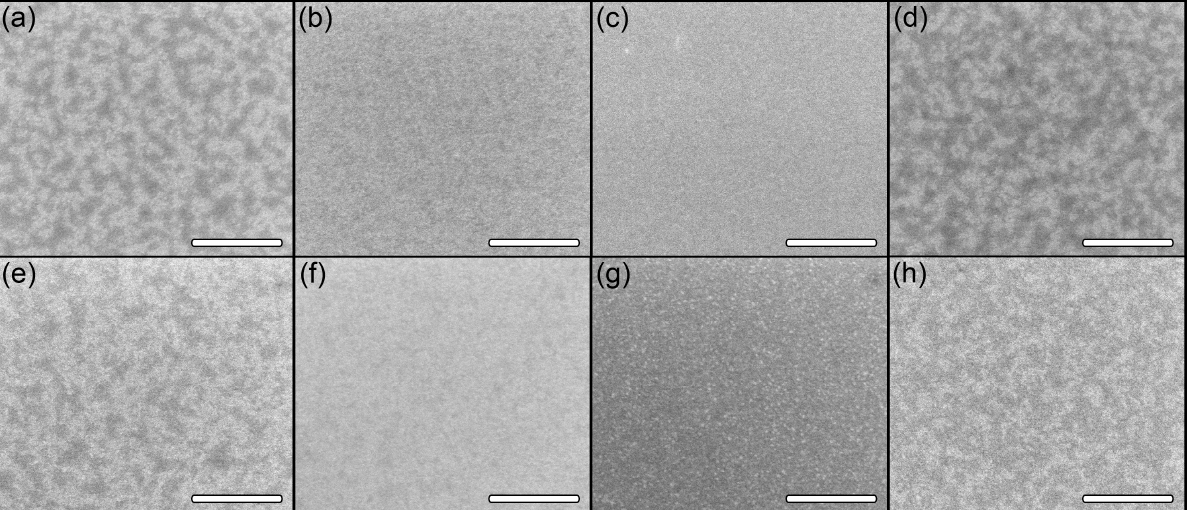
Figure 3. SEM images of modified areas before ( a – d ) and after ( e – h ) annealing stage for Ga ion doses (the dose is expressed in pC/µm 2 ) of 0.052 ( a , e ), 0.26 ( b , f ), and 10.4 ( c , g ) and the unmodified area ( d , h ). Scale bar is 300 nm.